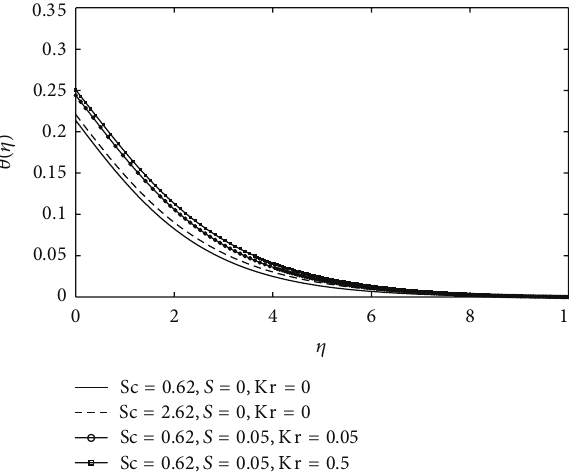
Sc = 0 .62,𝑆 = 0 ,Kr = 0 Sc = 2.62,𝑆 = 0 ,Kr = 0 Sc = 0 .62,𝑆 = 0 . 0 5,Kr = 0 . 0 5 Sc = 0 .62,𝑆 = 0 . 0 5,Kr = 0 .5 Figure 12: Temperature profiles for different values of Sc, 𝑆 , and Kr for Ha = 0.1 , Gr = 0.1 , Gc = 0.1 , Bi = 0.1 , Nc = 0.01 , and Pr = 0.72 . is more pronounced on temperature profiles for high Prandtl number